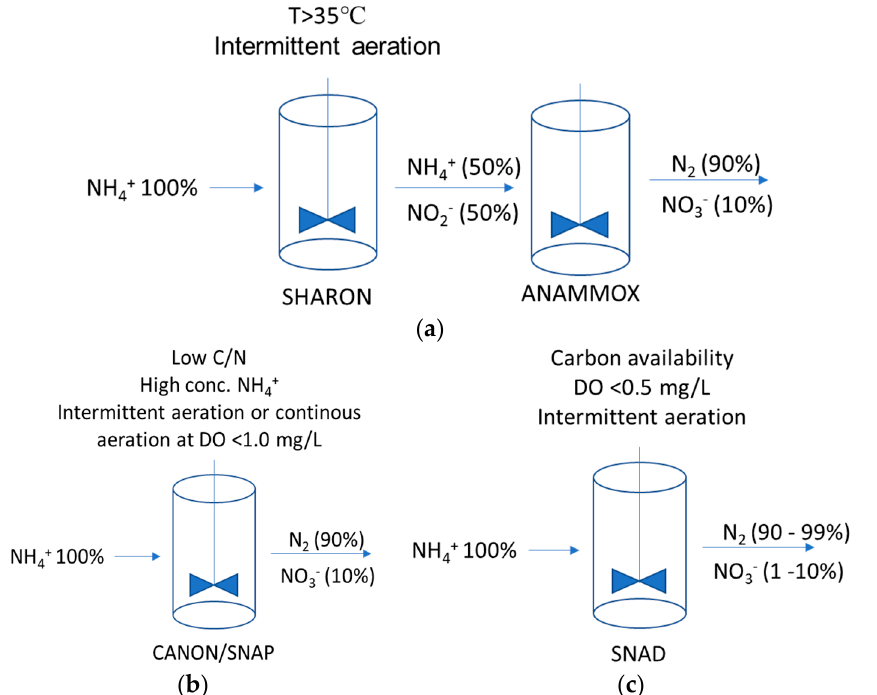
Figure 2. An overview of technologies based on the deammonification process: single reactor for high activity ammonium removal over nitrite (SHARON) ( a ) completely autotrophic nitrogen removal over nitrite CANON/ (single-stage nitrogen removal using anammox and partial nitritation SNAP ( b ) simultaneous partial nitrification, anammox, and denitrification SNAD ( c ).